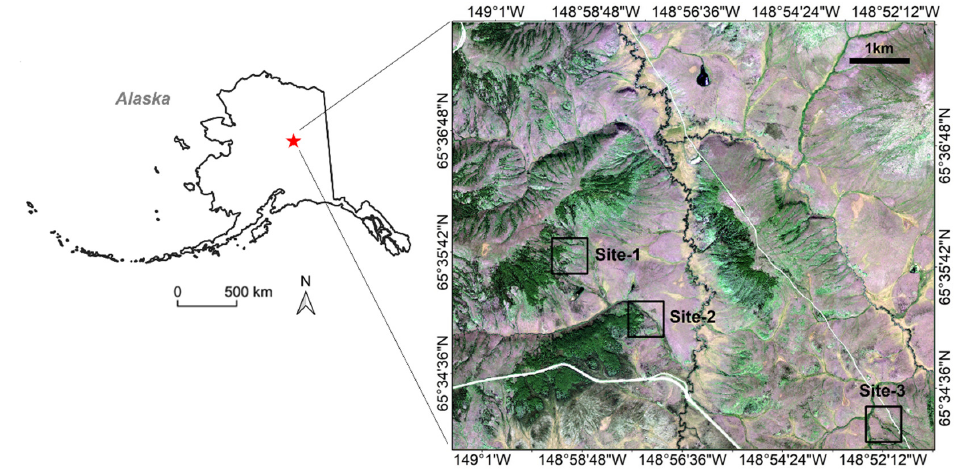
Figure 1. Overview of the study region displayed by the WV-2 composited RGB imagery of which the geographic location in Alaska is marked by a red star. Site-1, Site-2, and Site-3 are indicated by black